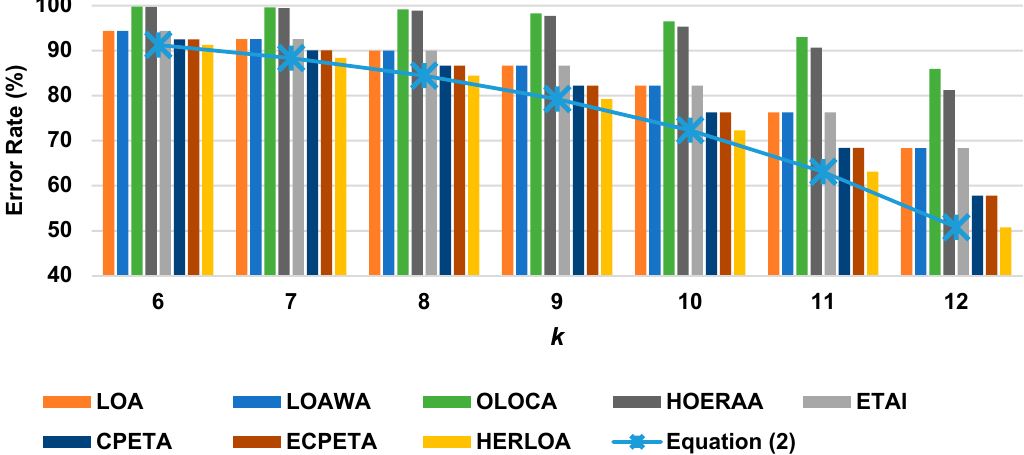
Figure 6. Comparison of error rates of 16-bit approximate adders at various values of design parameter k .